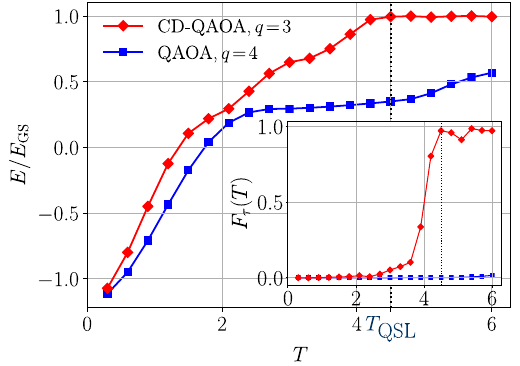
FIG. 2. Spin- 1 = 2 Ising model: energy minimization and the 1. Spin- 1 = 2 Ising model: energy minimization and the corresponding mean absolute error (inset, log scale) against corresponding many-body fidelity (inset) against protocol dura- protocol duration T for different system sizes using CD-QAOA tion T obtained using conventional QAOA (blue squares) and with circuit depths q ¼ 3 . System-size scaling of the variational CD-QAOA (red diamonds) with circuit depths p ¼ q= 2 ¼ 2 and q ¼ 3 , respectively. The dotted vertical line marks the quantum energy density suggests the results hold for larger systems. For the number of spins N ¼ 12 , 14, 16, 18, the Hilbert space sizes speed limit T . CD-QAOA outperforms conventional QSL are dim ð H Þ ¼ 224 , 687, 2250, 7685, respectively. The model parameters are the same as in Fig.